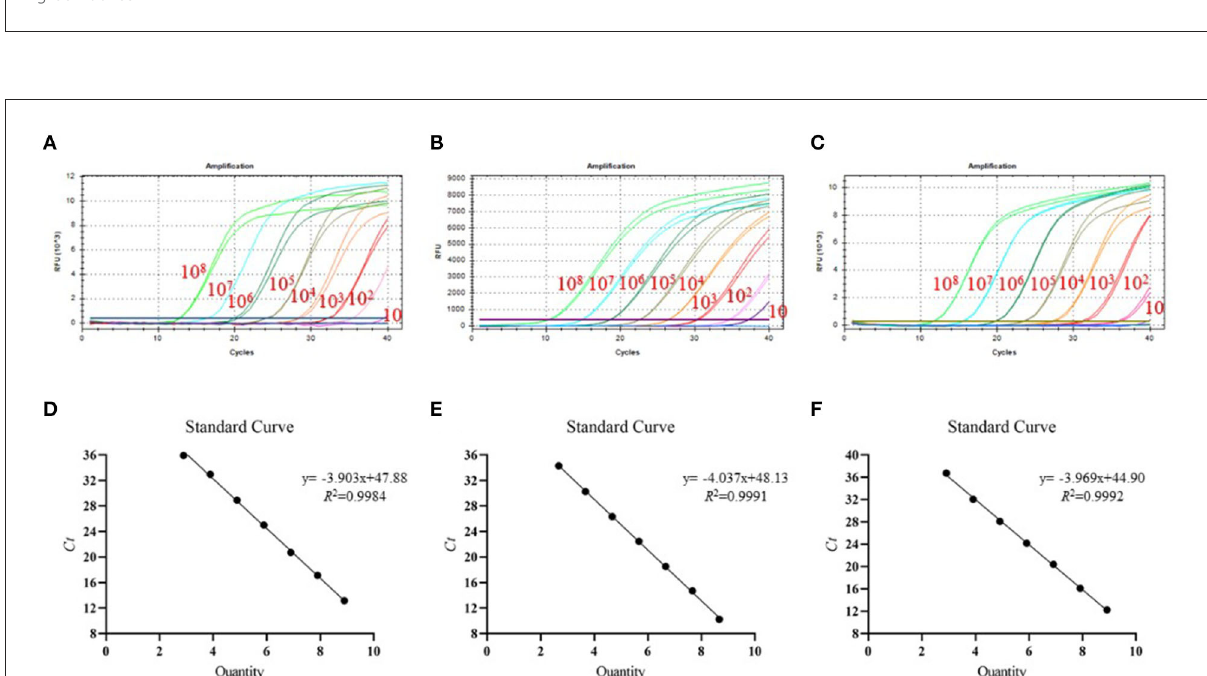
FIGURE1 Nucleotide sequence comparisons of the primer-target regions of B646L, CD2v, and MGF_360-14L from different ASFV strains. The primer-target regions of B646L, CD2v, and MGF_360-14L are heighted in yellow. In CD2v gene, different regions between the genotype I strains and genotype II strains are shown in red boxes; CD2v forward primer, probe, and reverse primer are shown in light blue, dark blue, and green boxes.